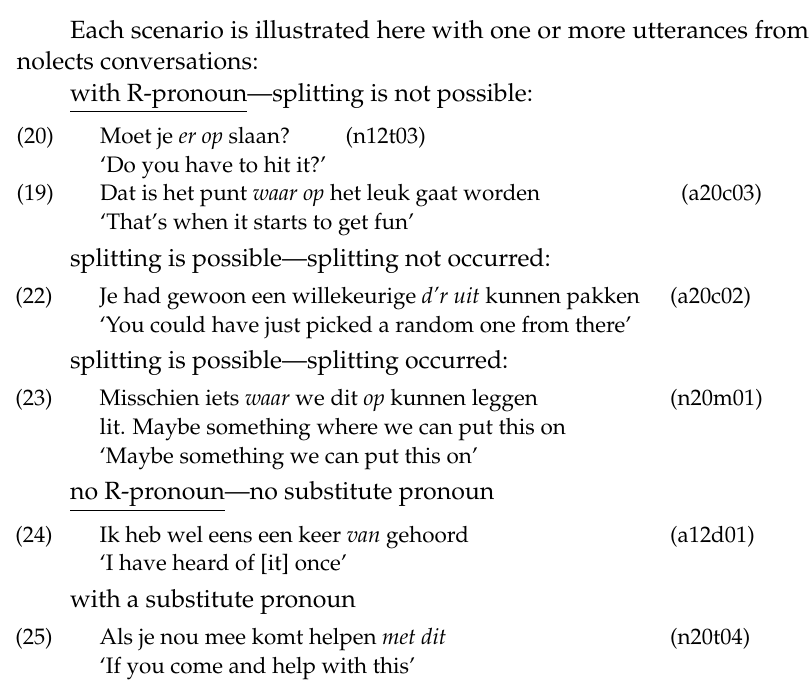
Figure 1. The structure of the linguistic data.